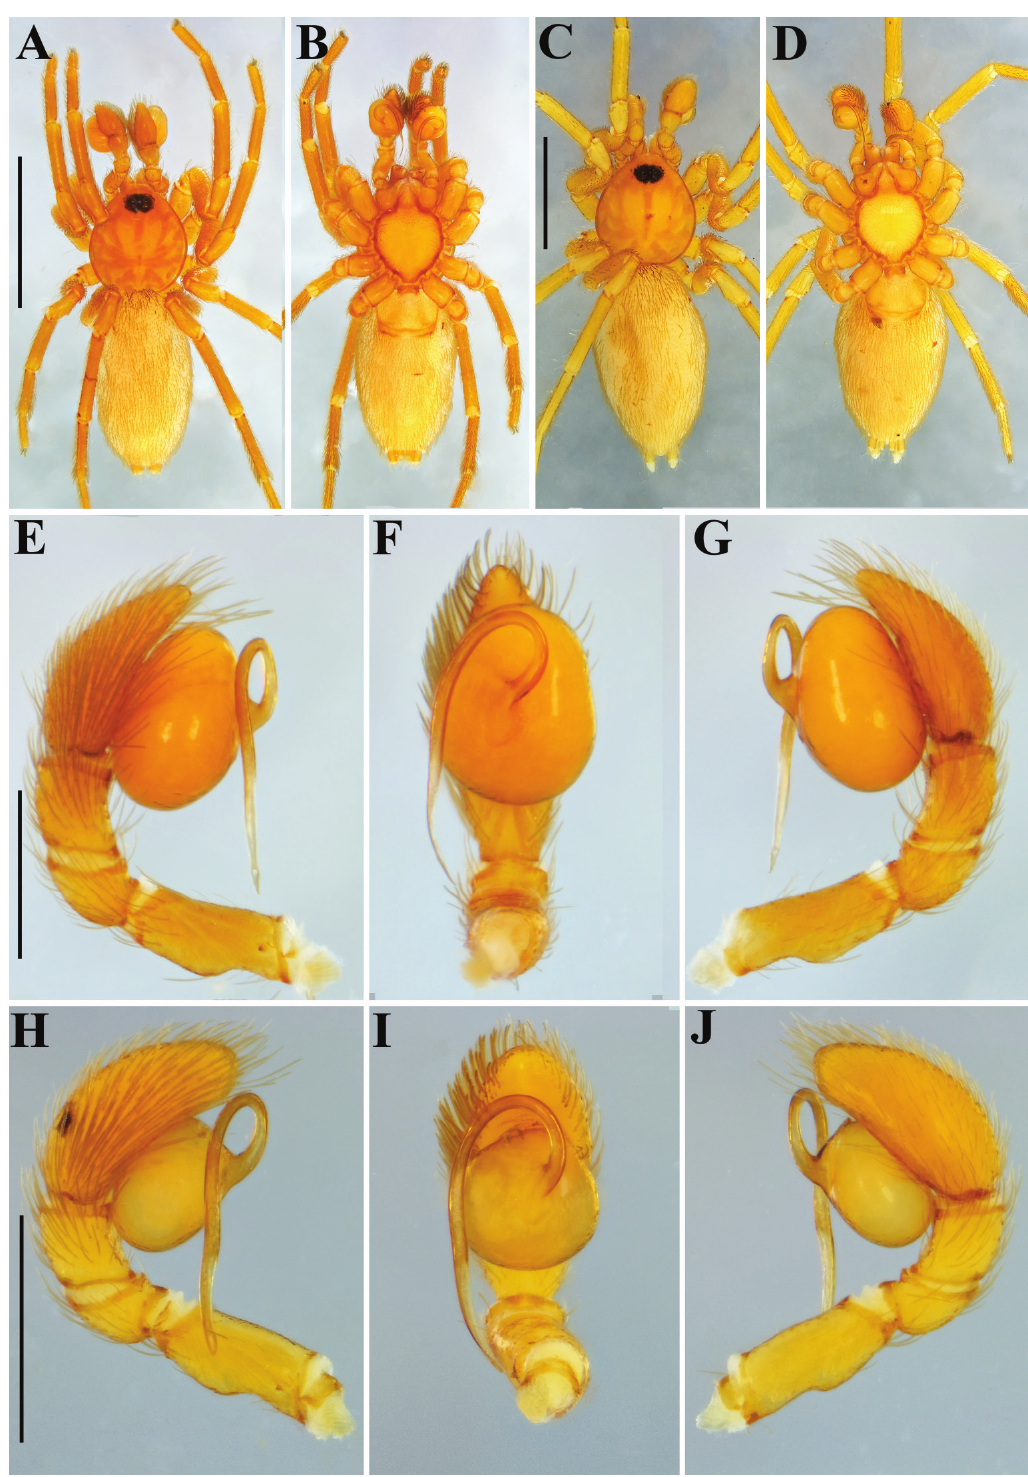
Fig. 3. A – B , E – G . Caponina bochalema sp. nov., ♂, holotype (IAvH-I 3757). A . Habitus, dorsal view. B . Habitus, ventral view. E . Left palp, retrolateral view. F . Left palp, ventral view. G . Left palp, prolateral view. – C – D , H – J . Caponina huila sp. nov., ♂, holotype (IAvH-I 3761). C . Habitus, dorsal view. D . Habitus, ventral view. H . Left palp, retrolateral view. I . Left palp, ventral view. J . Left palp, prolateral view. Scale bars: A–D = 1.5 mm; E–J = 1